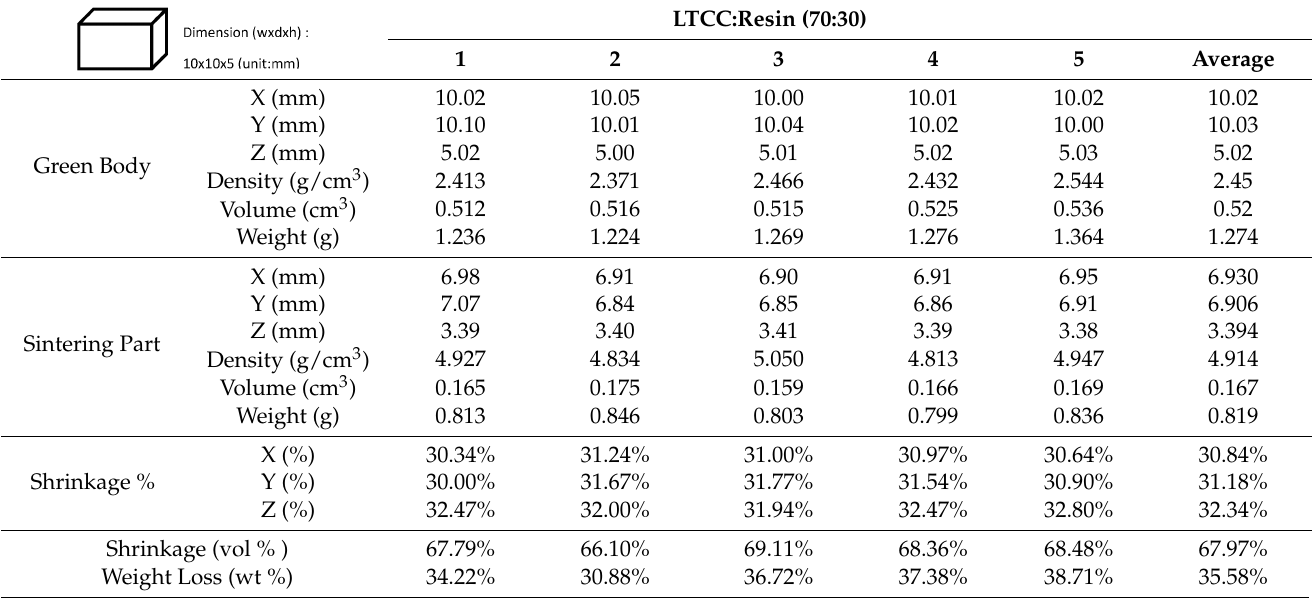
Table 2. Dimensions of the LTCC specimen before and after sintering.